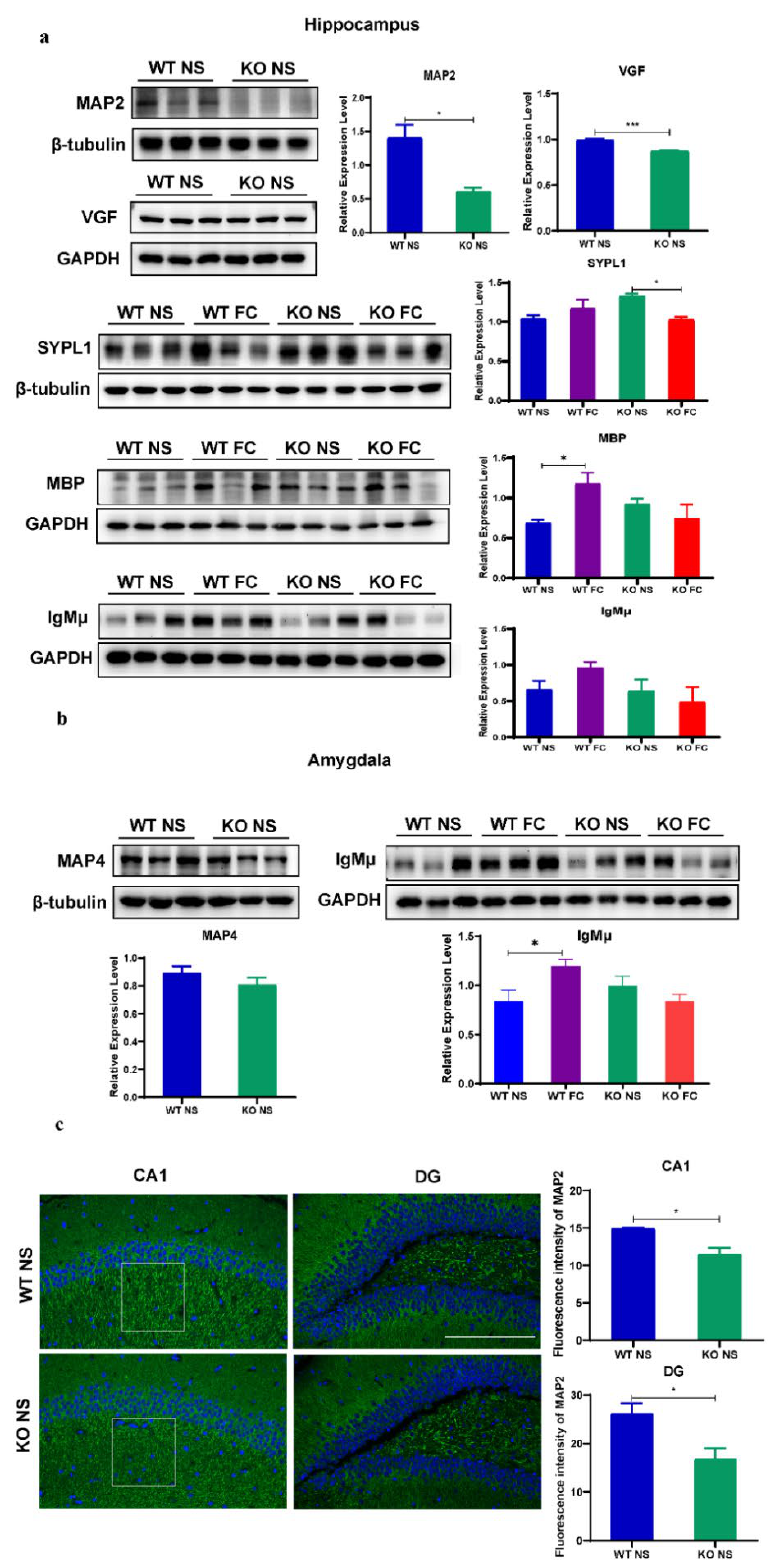
Figure 7. Validation of the proteomic data. ( a ) Representative Western blots and quantified data of the selected DEPs including MAP2, VGF, SYPL1, MBP, and IgM µ from the hippocampus data. Data are presented as the means ± SEM (one-way ANOVA followed by Bonferroni’s multiple comparison test or Student’s t -test, n = 3). * p < 0.05 and *** p < 0.001. ( b ) Representative Western blots and quantified